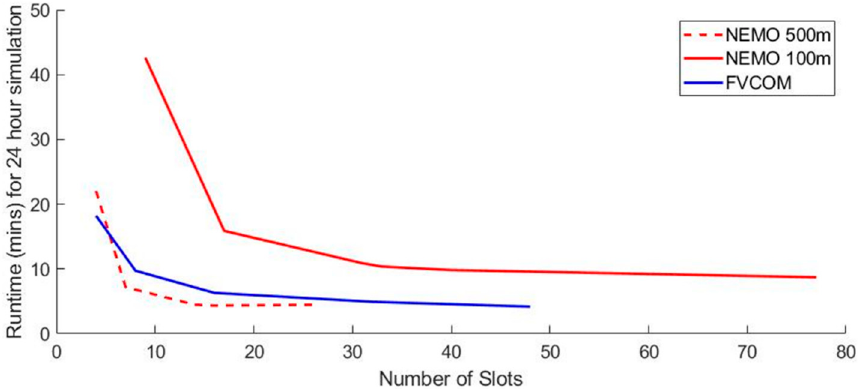
Figure 10. The run time for a 24 h simulation versus the number of slots on the General Purpose Science Computing platform of Shared Services of Canada, with the FVCOM (solid blue curve), the NEMO’s 500 m (BoF500, dashed red curve) and 100 m (SJAP100, solid red curve) configurations.